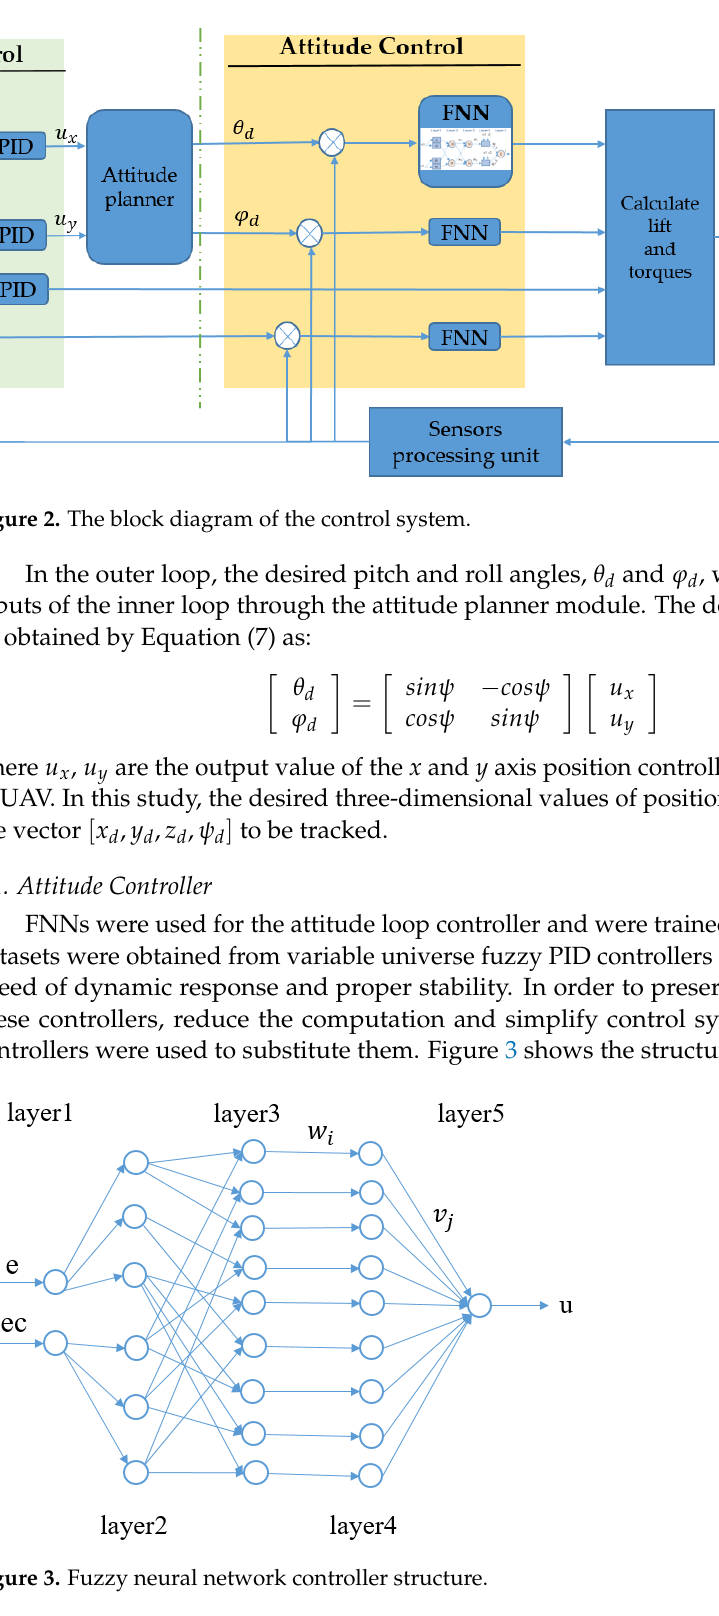
Figure 2. The block diagram of the control system.